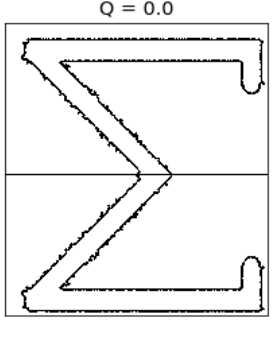
Figure 4. A sigma symmetry axis. Q is the asymmetry measure of object.